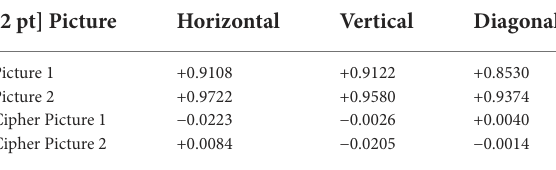
TABLE 3 Adjacent pixels correlation of pictures.